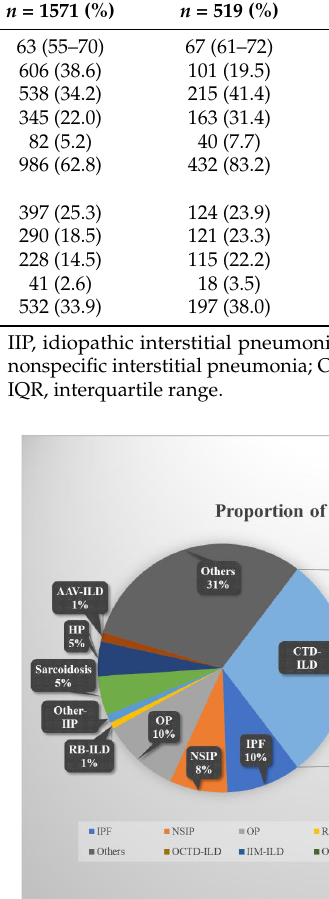
Figure 2. Percentage of ILD subtypes compared to the total ILD population. ILD, interstitial lung disease; IPF, idiopathic pulmonary fibrosis; NSIP, nonspecific interstitial pneumonia; OP, organizing pneumonia; CTD-ILD, connective tissue disease-associated ILD; HP, hypersensitivity pneumonitis; AAV, anti-neutrophil cytoplasmic antibodies-associated vasculitis; IIM, idiopathic inflammatory myopathies; OS, overlap syndrome; SS, Sjögren’s syndrome; RA, rheumatoid arthritis; SLE, systemic lupus erythematosus; SSc, systemic sclerosis; OCTD-ILD, other CTD-ILD.